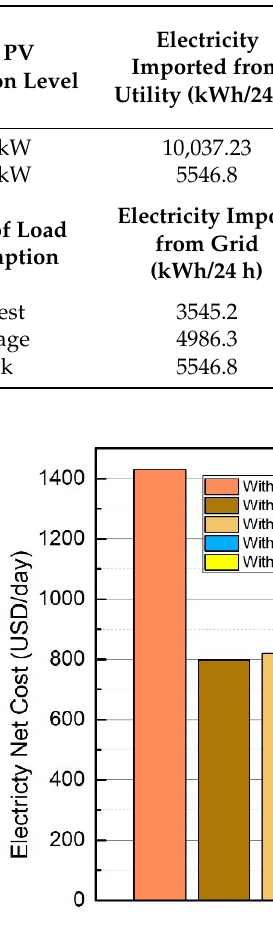
Figure 12. Cost analysis of electricity net cost (USD) in different scenarios. Table 7. Techno-economic price comparison of different types of components connected with the proposed system.